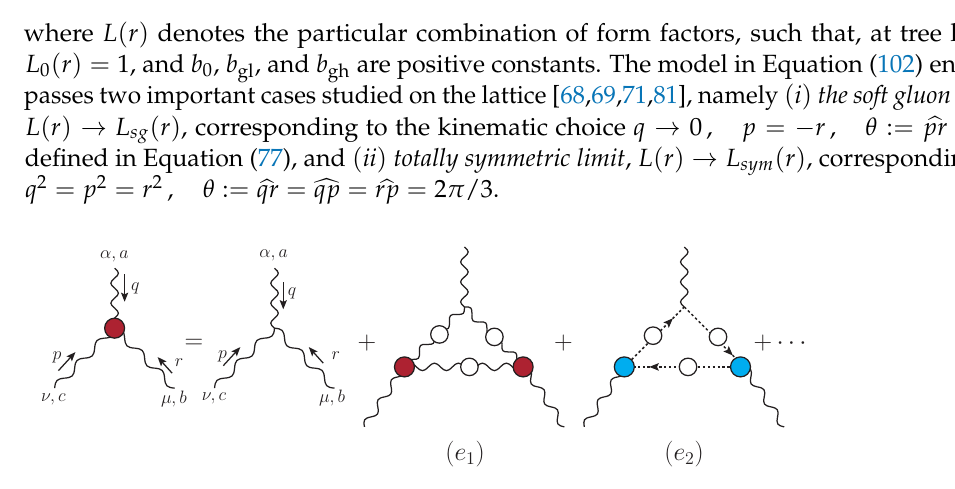
Figure 16. The SDE of the three-gluon vertex at the one-loop dressed level. Diagrams ( e 1 ) and ( e 2 ) are the gluon and the ghost triangle contributions entering the skeleton expansion of the three-gluon vertex.